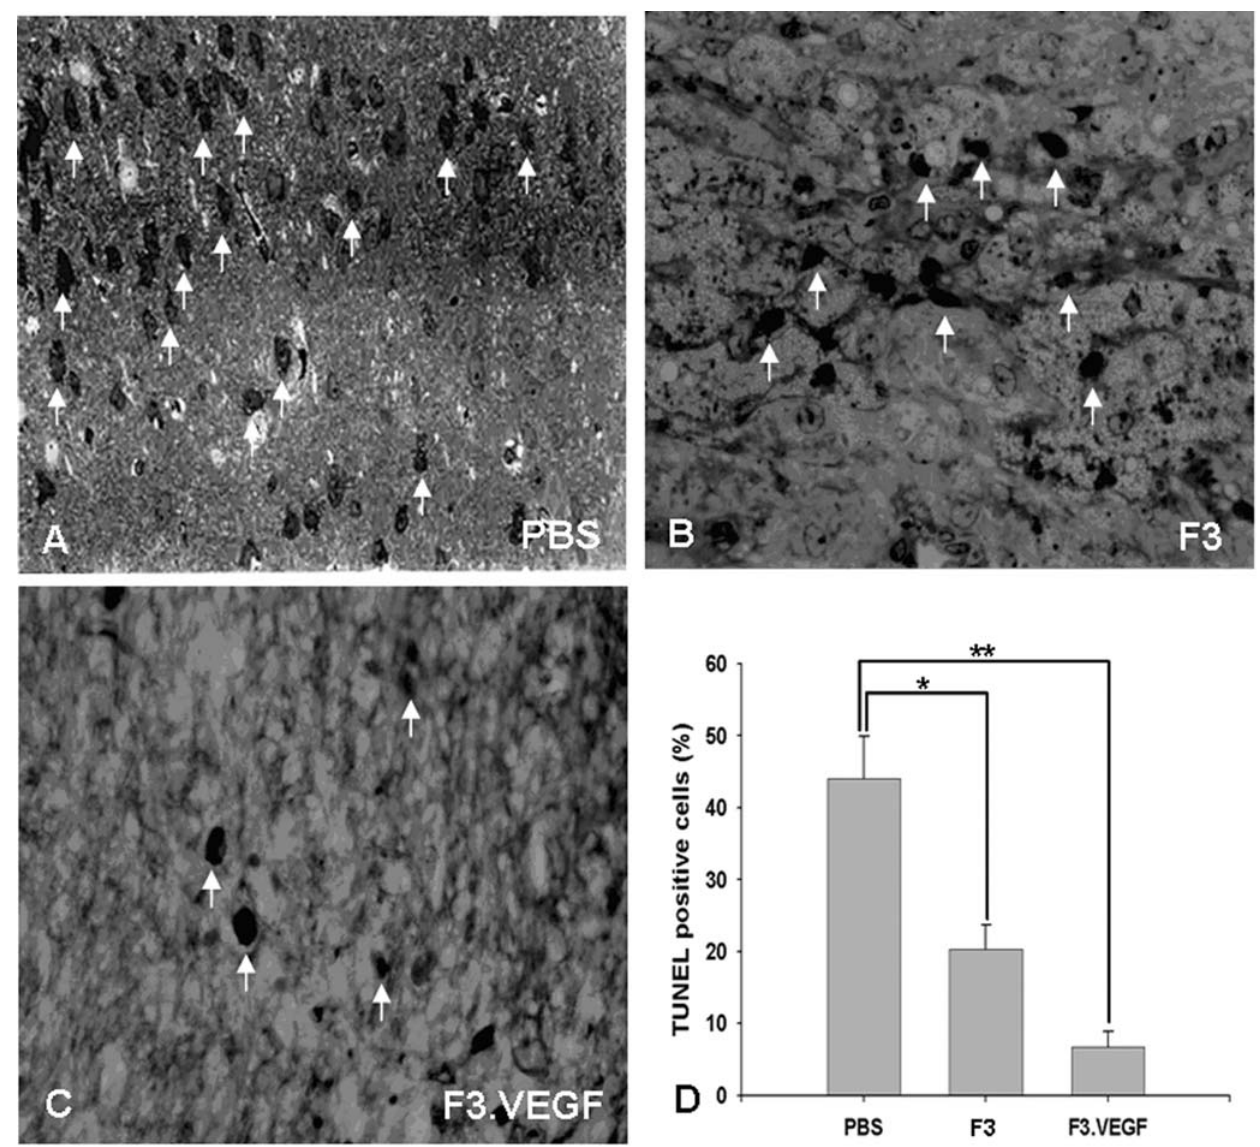
ICH-F3.VEGF groups (C). Bar indicates 100 m m.